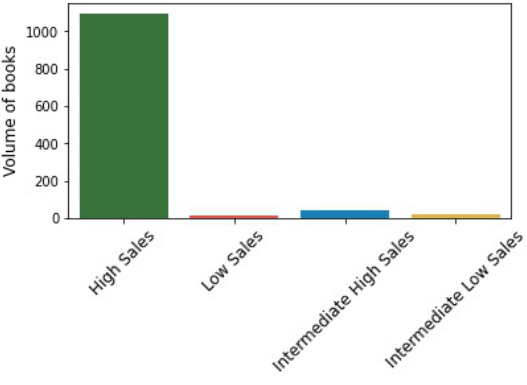
Figure 7. Distribution of the volume of books for each of the clustering segmentations. The results show a significant data imbalance between the different